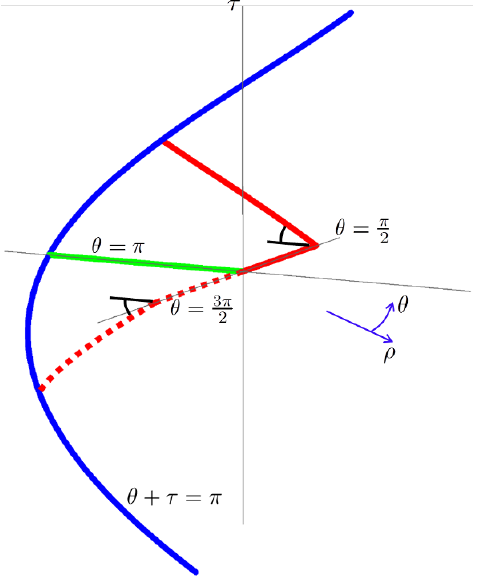
Figure 7 . Sketch of optimal circuits. The vertical axis is (cid:28) and the horizontal plane is described by the radius (cid:26) and the azimuthal angle (cid:18) , while the y direction is suppressed. The unpenalized minimum (green) goes straight out along ( (cid:18); (cid:28) ) = ( (cid:25); 0). The optimal circuit in the penalized geometry is well-approximated by the segmented circuit U s ((cid:22) s ) in red: the (cid:12)rst segment, U a ((cid:22) s ), goes straight out along ( (cid:18); (cid:28) ) = ( (cid:25)= 2 ; 0) until reaching (cid:26) 1 , whereupon the second segment, U b ((cid:22) s ), curves upwards to ( (cid:18); (cid:28) ) = (3 (cid:25)= 4 ; (cid:25)= 4). One sees that, relative to the unpenalized minimum, the segmented circuit arrives at a di(cid:11)erent but equally valid point along the one-parameter family of allowed end-points given by (cid:18) + (cid:28) = (cid:25) (blue), but with a shorter length. The dashed path has an identical length, and is simply the segmented circuit rotated by 180 o about the ( (cid:18); (cid:28) ) = ( (cid:25); 0) axis.